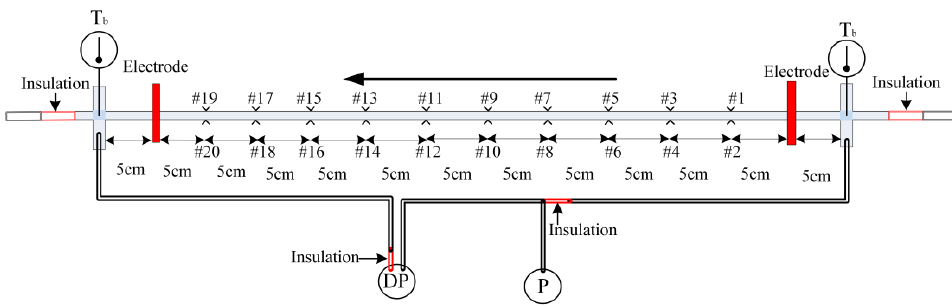
Figure 1. Schematic diagram of the experimental loop.